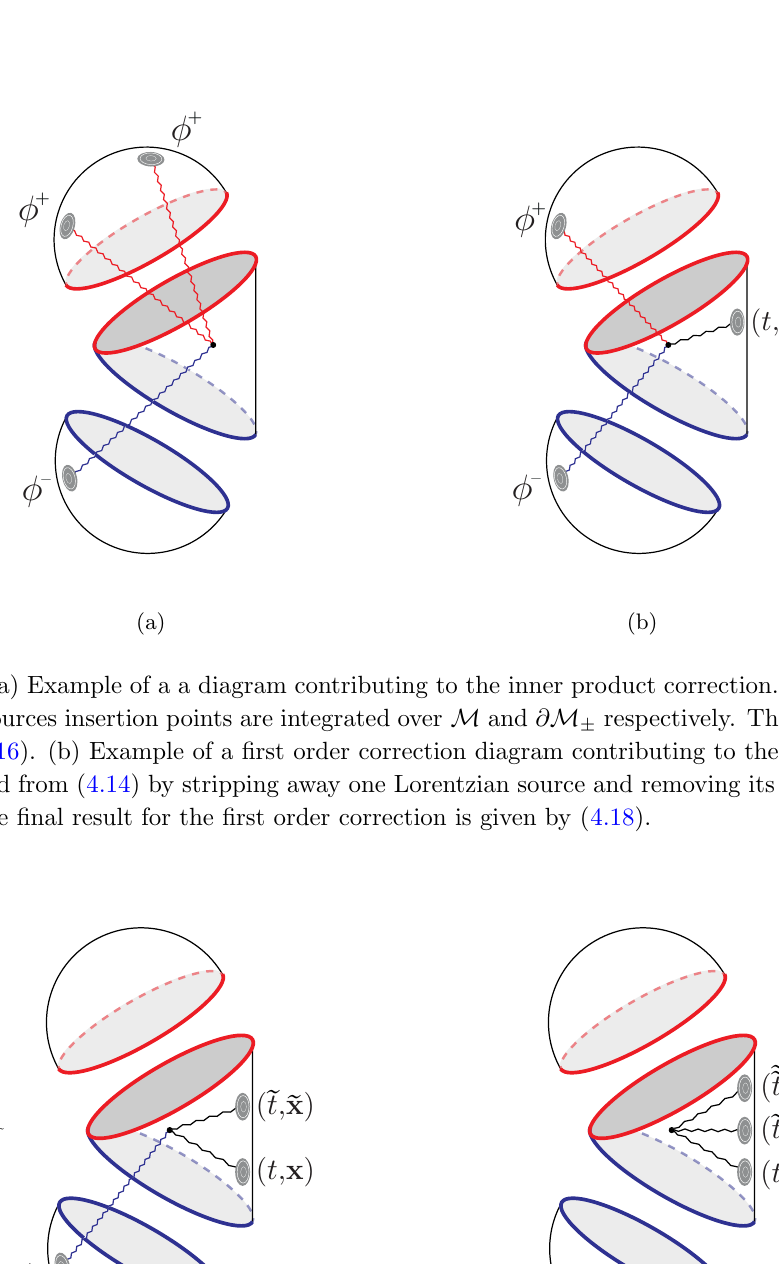
with (cid:30) E de(cid:12)ned in (4.5). In analogy with the non-interacting case [11], the left hand side, which reduces to the computation of the generating functional for a source (cid:30) E on the boundary of the Euclidean AdS, matches [4].